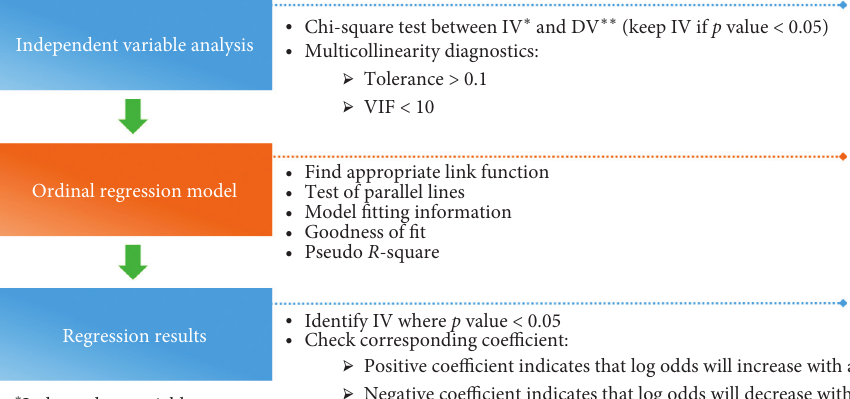
Independent variable analysis